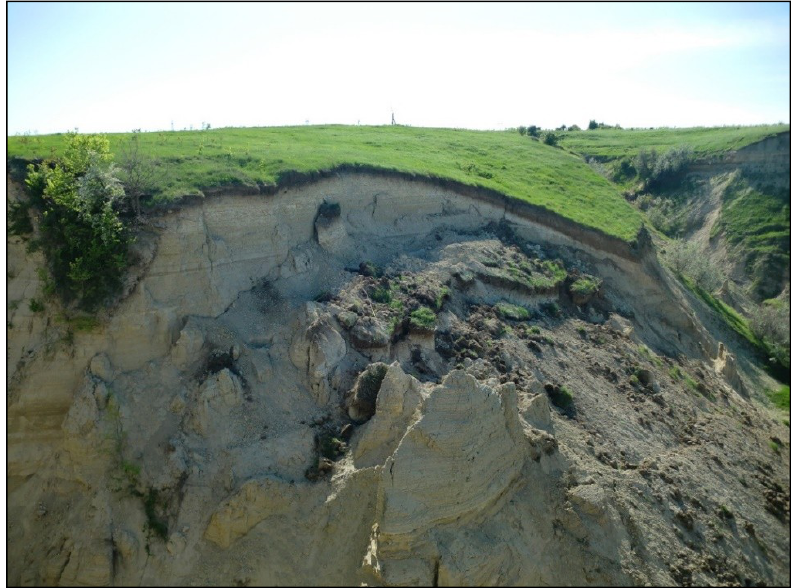
Figure 1. Sand columns created inside the Băiceni-Cucuteni gully (Romania), after the collapse from May 2013 (nowadays they do not exist anymore).